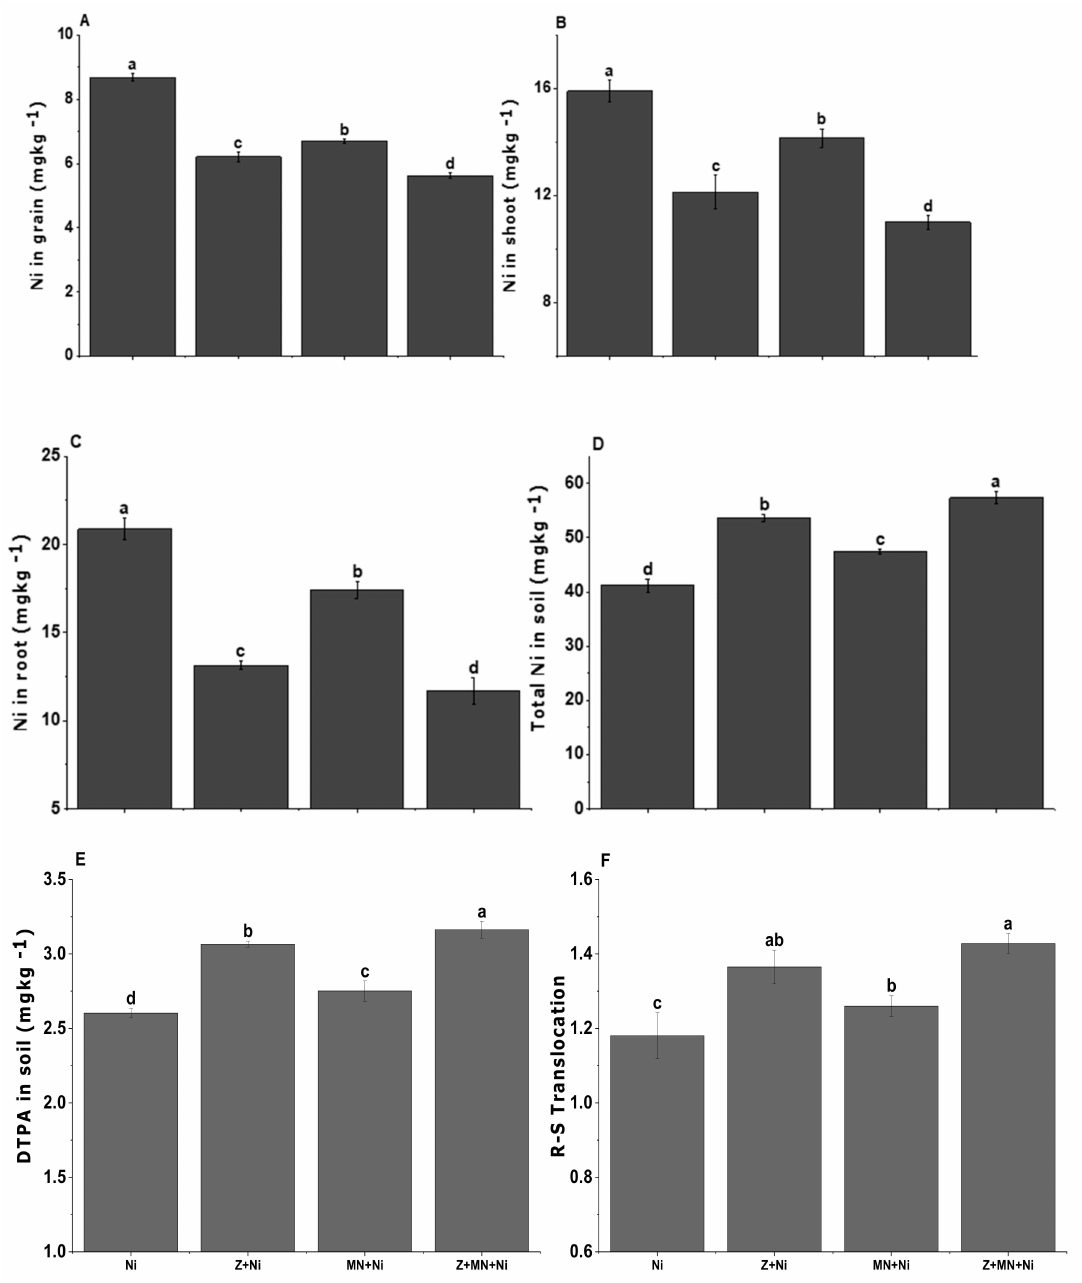
Figure 4. Ni concentration in di ff erent parts grain ( A ), shoot ( B ), root ( C ) of sesame plants and in soil ( D , E ) and its R-S translocation ( F ) with di ff erent treatments applied under normal and Ni stressed soil conditions. Values sharing the same letter(s) in bars are statistically non-significant with each other at p < 0.05; the values are mean ± standard error ( n =